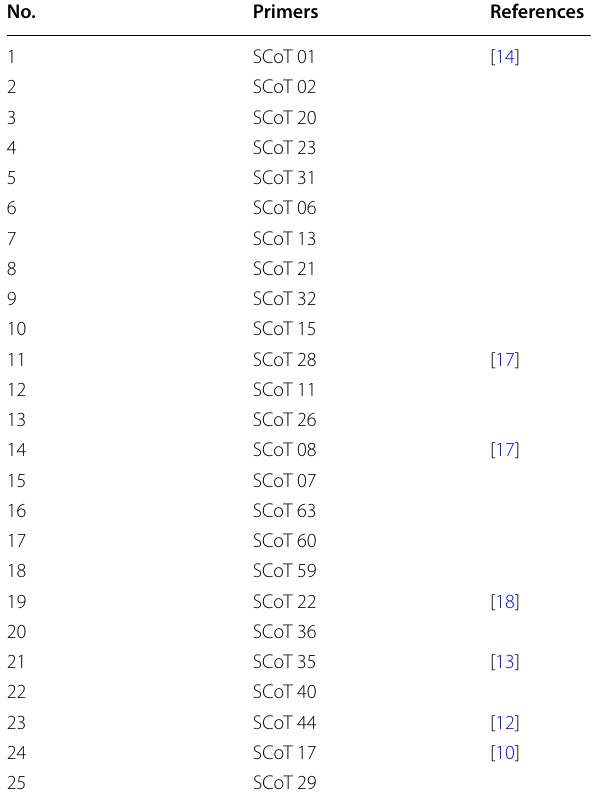
Table 2 SCoT markers for PCR analysis of ryegrass cultivars No.